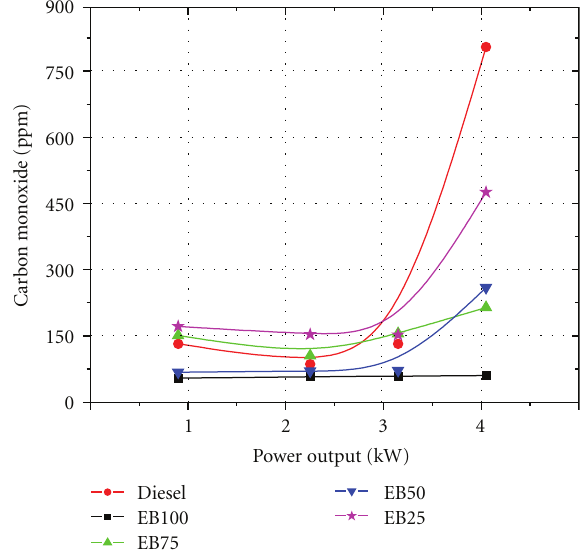
Figure 7: Unburned hydrocarbon emissions at various power output.